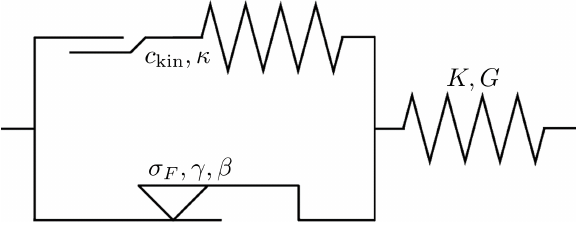
Figure 3. Rheological representation of the material model with the material